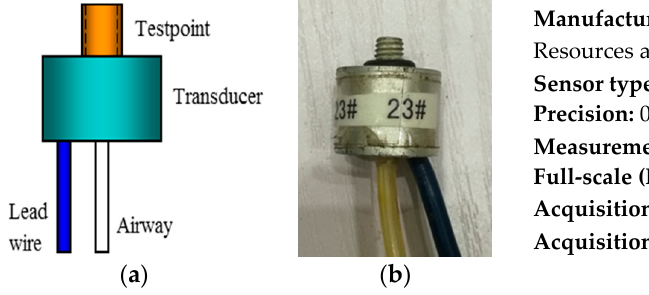
Figure 5. Constitution and performance parameters for the pressure sensor. ( a ) sensor components; ( b ) actual photograph; and ( c ) performance parameters.